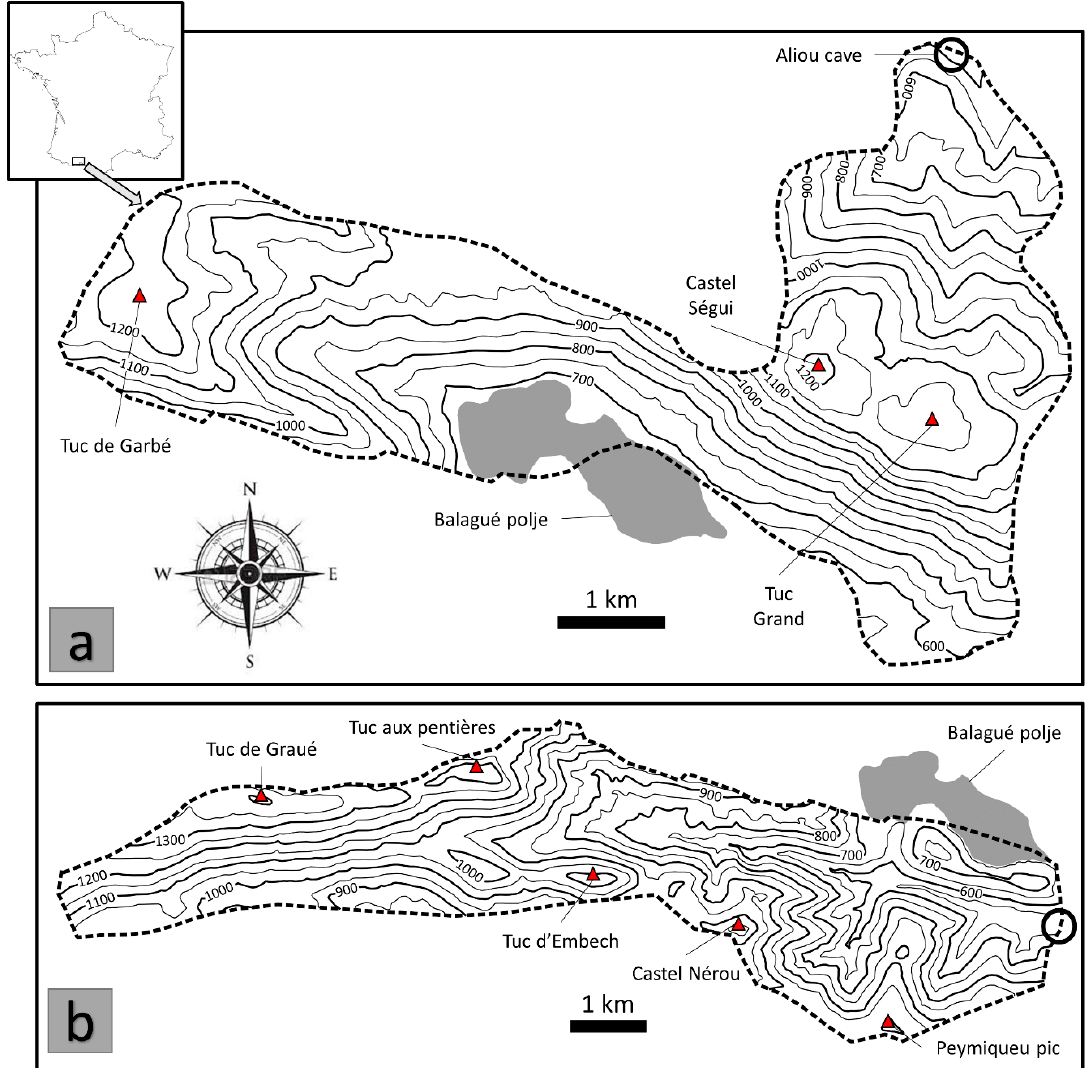
Figure 1. Localization of the Aliou ( a ) and Baget ( b ) karstic watersheds in the south of France with physiographic maps, modified from [30]. The circle indicates the position of the hydrometric station located at the outlet of the basin.